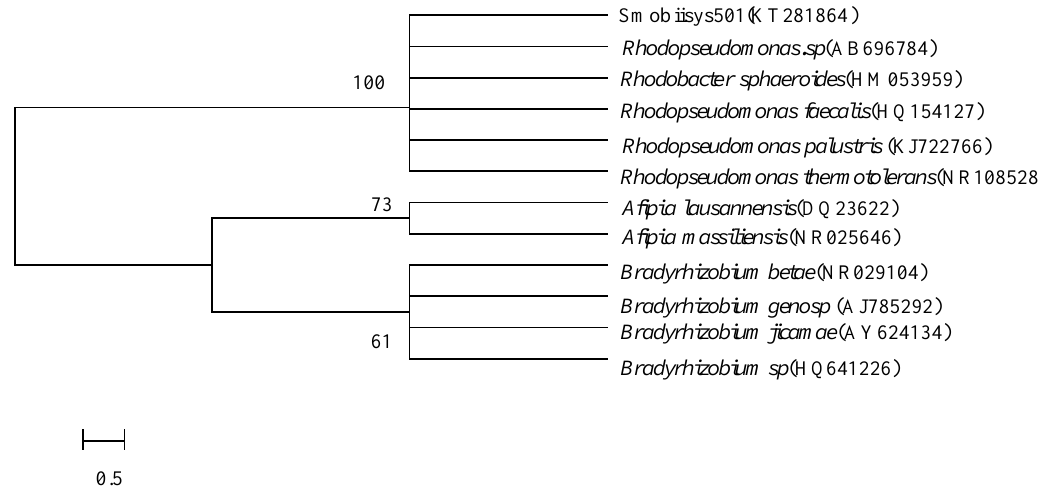
Figure 2. Phylogenetic tree of Smobiisys501 based on the 16S rDNA gene homology.